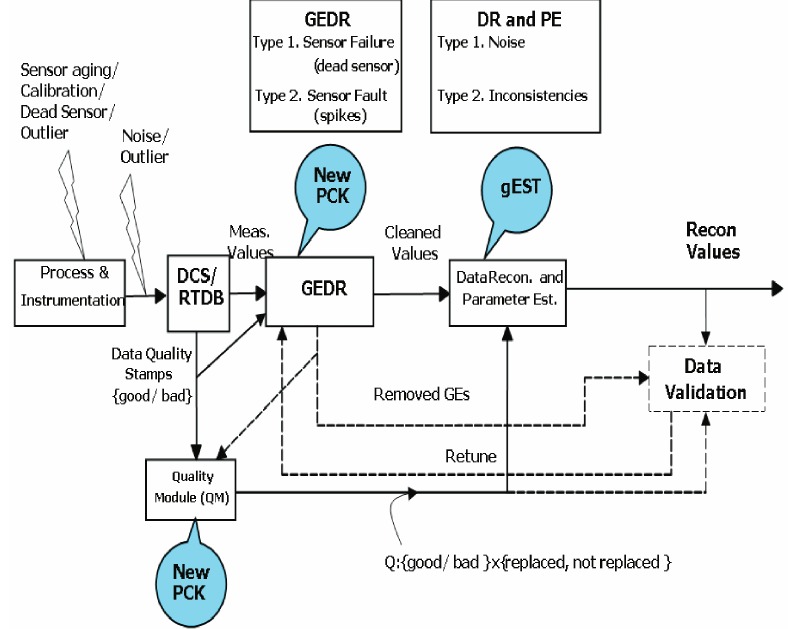
Figure 1. Overview of modules relevant to gross error detection and replacement (GEDR) and quality module